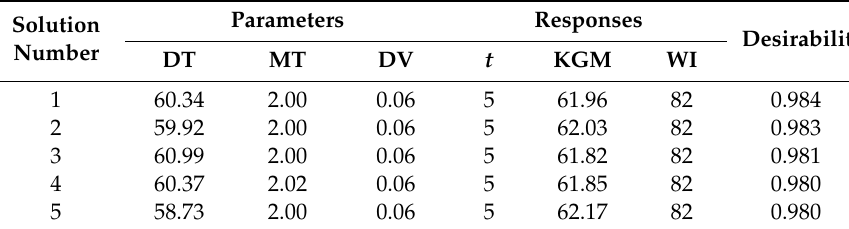
Table 4. Optimization solutions for the konjac vacuum drying.